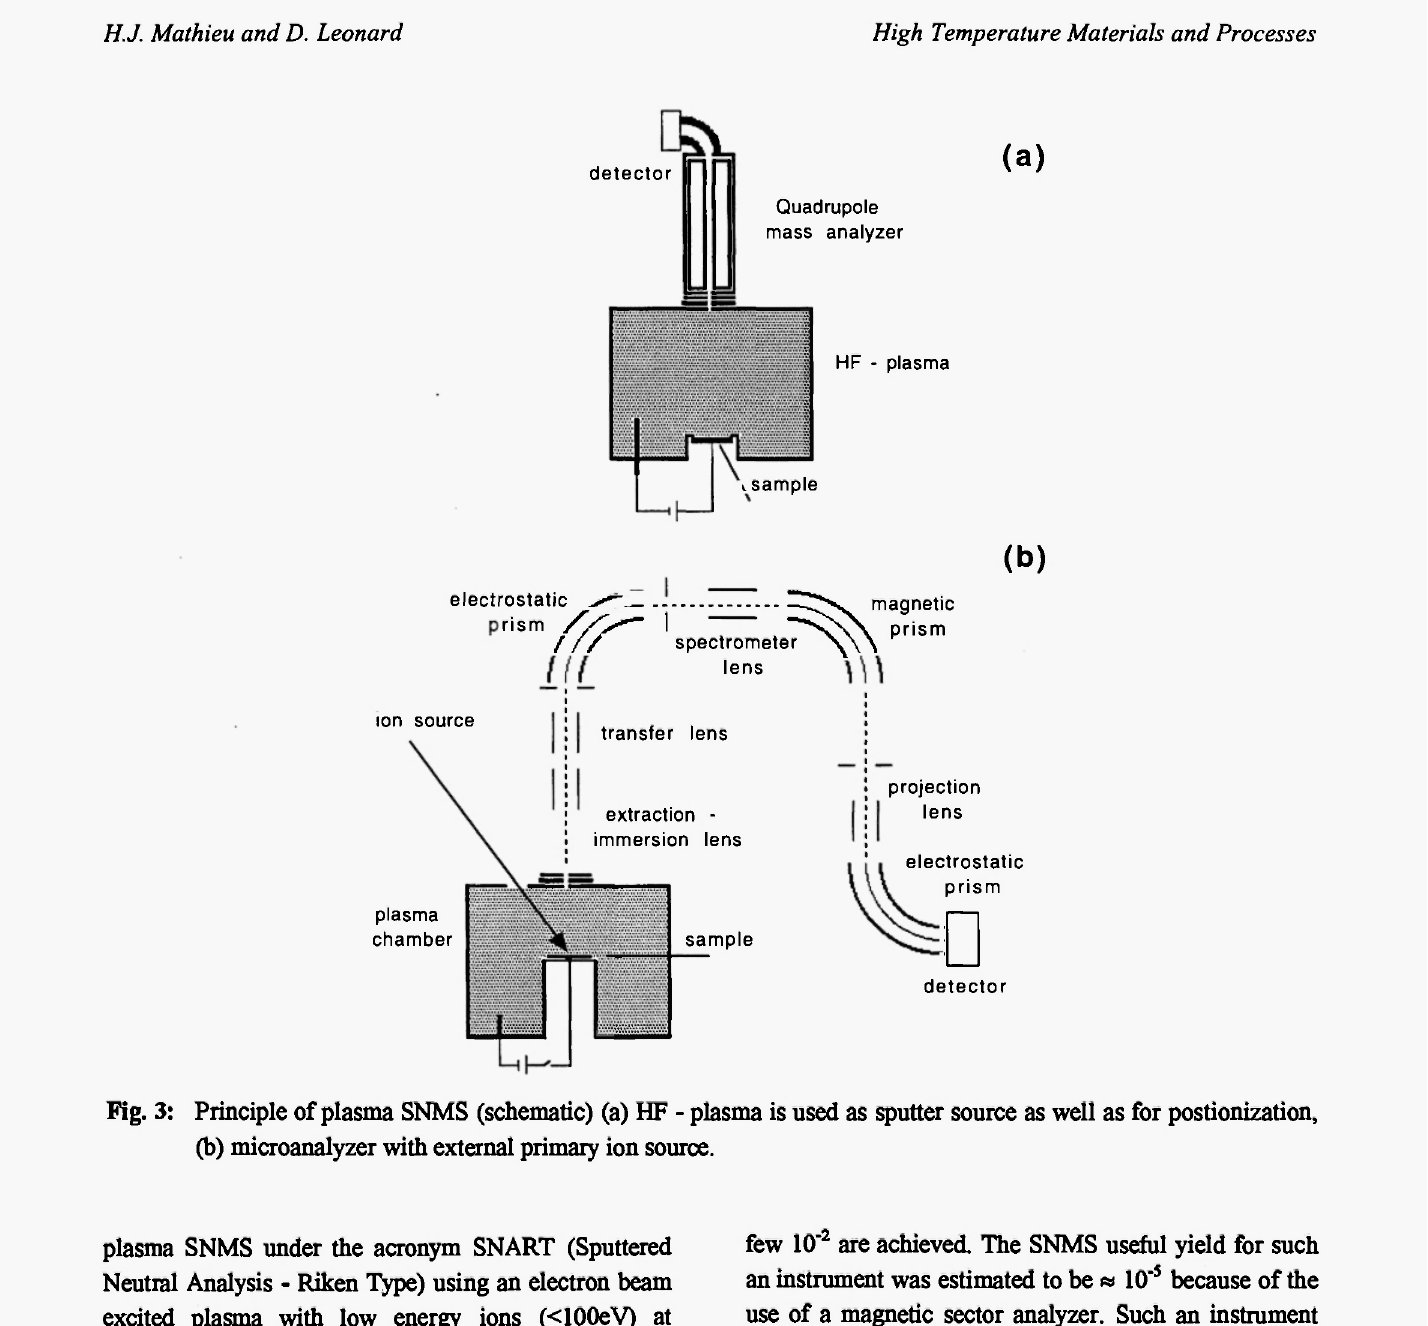
Fig. 3: Principle of plasma SNMS (schematic) (a) HF - plasma is used as sputter source as well as for postionization, (b) microanalyzer with external primary ion